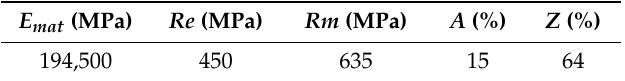
Table 2. Mechanical parameters for S355J0 where Z is a contraction.